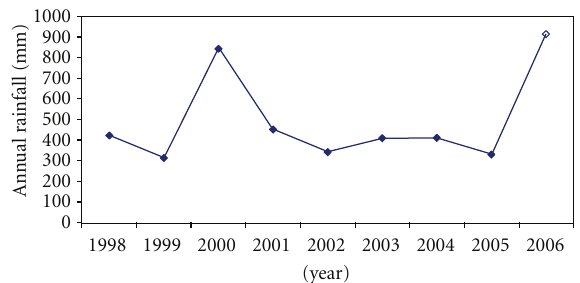
Figure 1: Annual rainfall amounts in Xade during the study period.